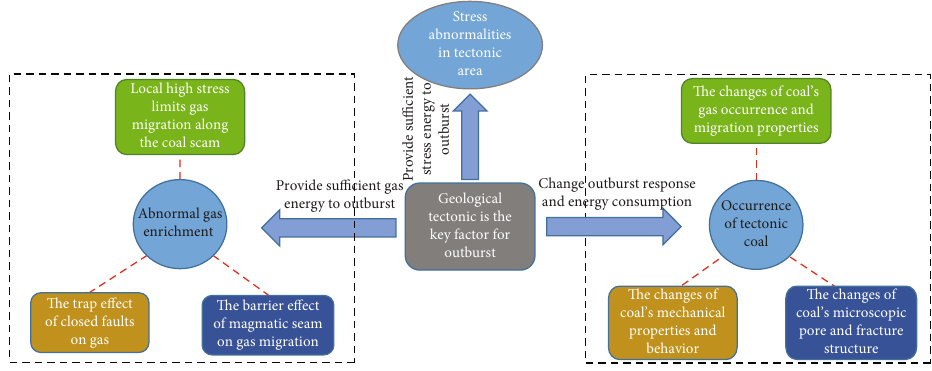
Figure 6: Key e ff ects of tectonic movement in outbursts [31, 43, 107, 119, 124, 127].